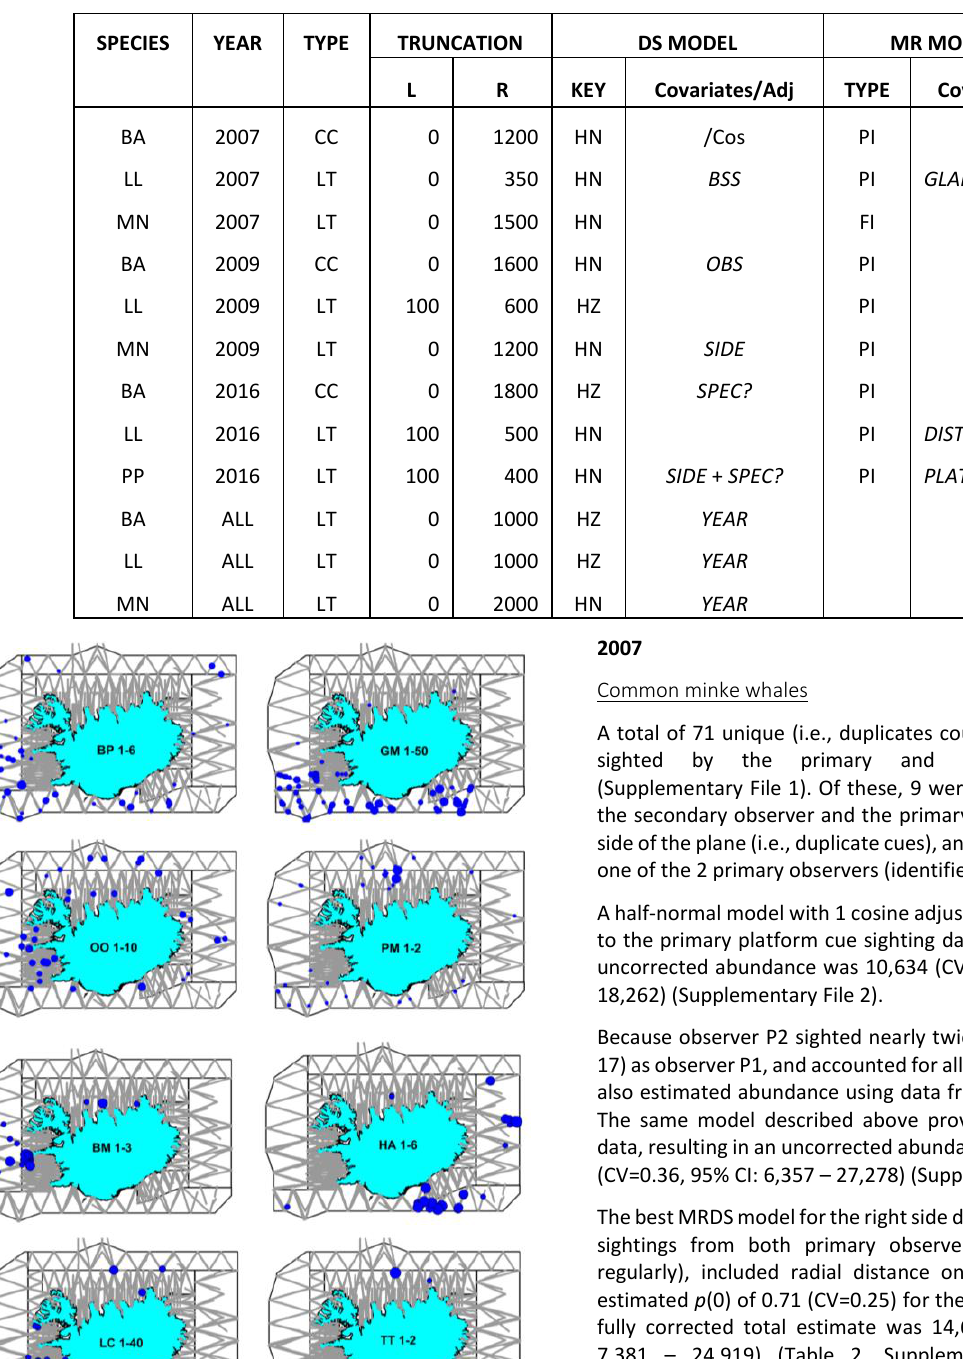
Table 1. Model specifications for detection functions by survey and species. All DS (distance) and MRDS (mark-recapture) models include perpendicular distance (line transect = LT) or radial distance (cue counting = CC) as a covariate. BA – common minke whale; LL – white-beaked dolphin; MN – humpback whale; PP – harbour porpoise; HN – half normal; HZ – hazard rate; BSS – Beaufort sea state; OBS – observer identity; SIDE – side of plane; SPEC? – species identification certainty; YEAR – survey year; GLARE – glare severity; SIGHT – sightability; PLAT – platform; FI – assumed full independence; PI – assumed point